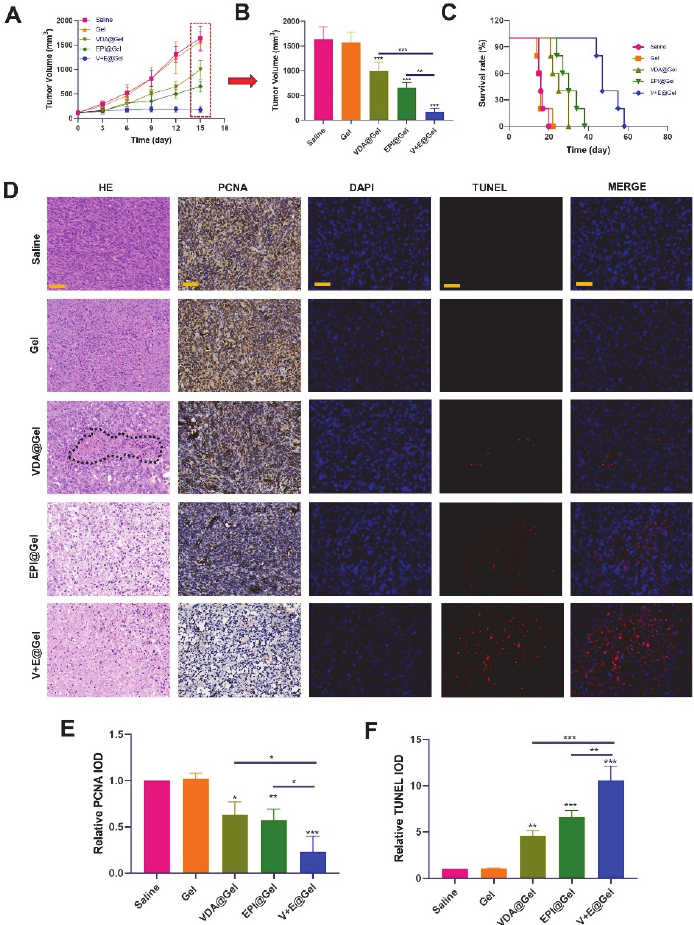
Figure 2. In vivo antitumor efficacy of V+E@Gel. ( A ) Change in tumor volume from each treatment group during 15 days; ( B ) Relative tumor volume from each treatment group on day 15; ( C ) Survival rate of mice from each treatment group during 60 days evaluation; ( D ) Histological analysis of tumor slices from each treatment group by H&E staining, immunohistochemical analysis and TUNEL assay, scale bar = 50 µ m; Semi-quantitative analysis of ( E ) PCNA expression and ( F ) TUNEL expression in tumor tissues. All data are shown as mean ± S.D. ( n = 5), * p < 0.05, ** p < 0.01, and *** p < 0.001 vs. Saline.